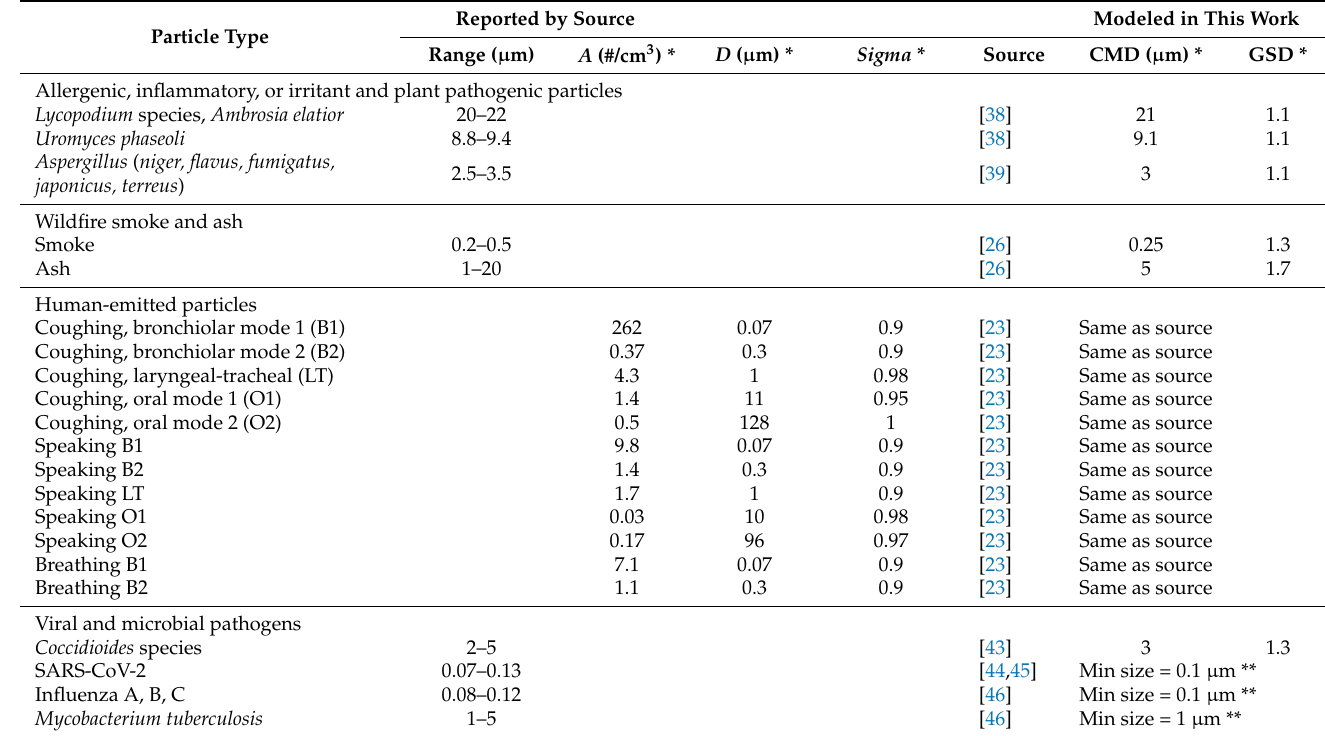
Table 1. Literature values, lognormal parameters for modeled particle type modes, and assumed minimum infectious particles sizes for different